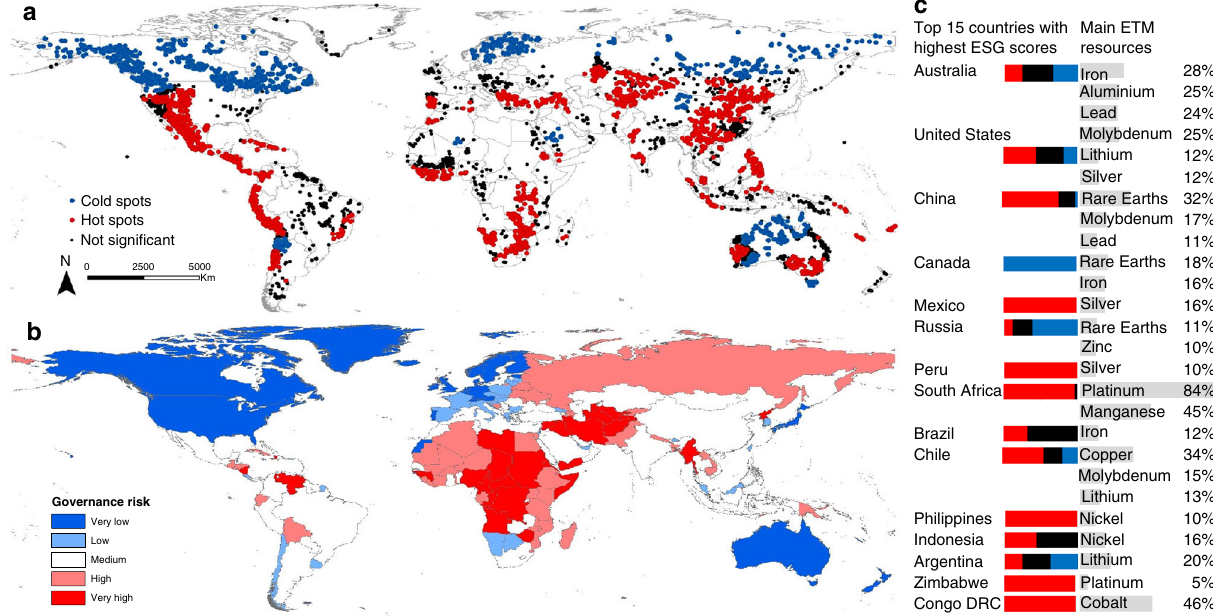
Fig. 2 Geographic distribution of environmental social and governance risks. a Global map of social and environmental hot spots and cold spots. Clusters of signi fi cantly low environmental and social scores (i.e., cold spots) and clusters of signi fi cantly high environmental and social scores (i.e., hot spots) are determined according to the sum of the six environmental and social dimensions. Mining projects outside hot spots and cold spots appear as black dots. b Global governance map. Source: Worldwide Governance Indicators, World Bank. c Top 15 countries according to the sum of individual mining projects ’ risk scores and the percentage of main energy transition metal resources in each country. Coloured bars indicate the dominance of hot spots or cold spots in the